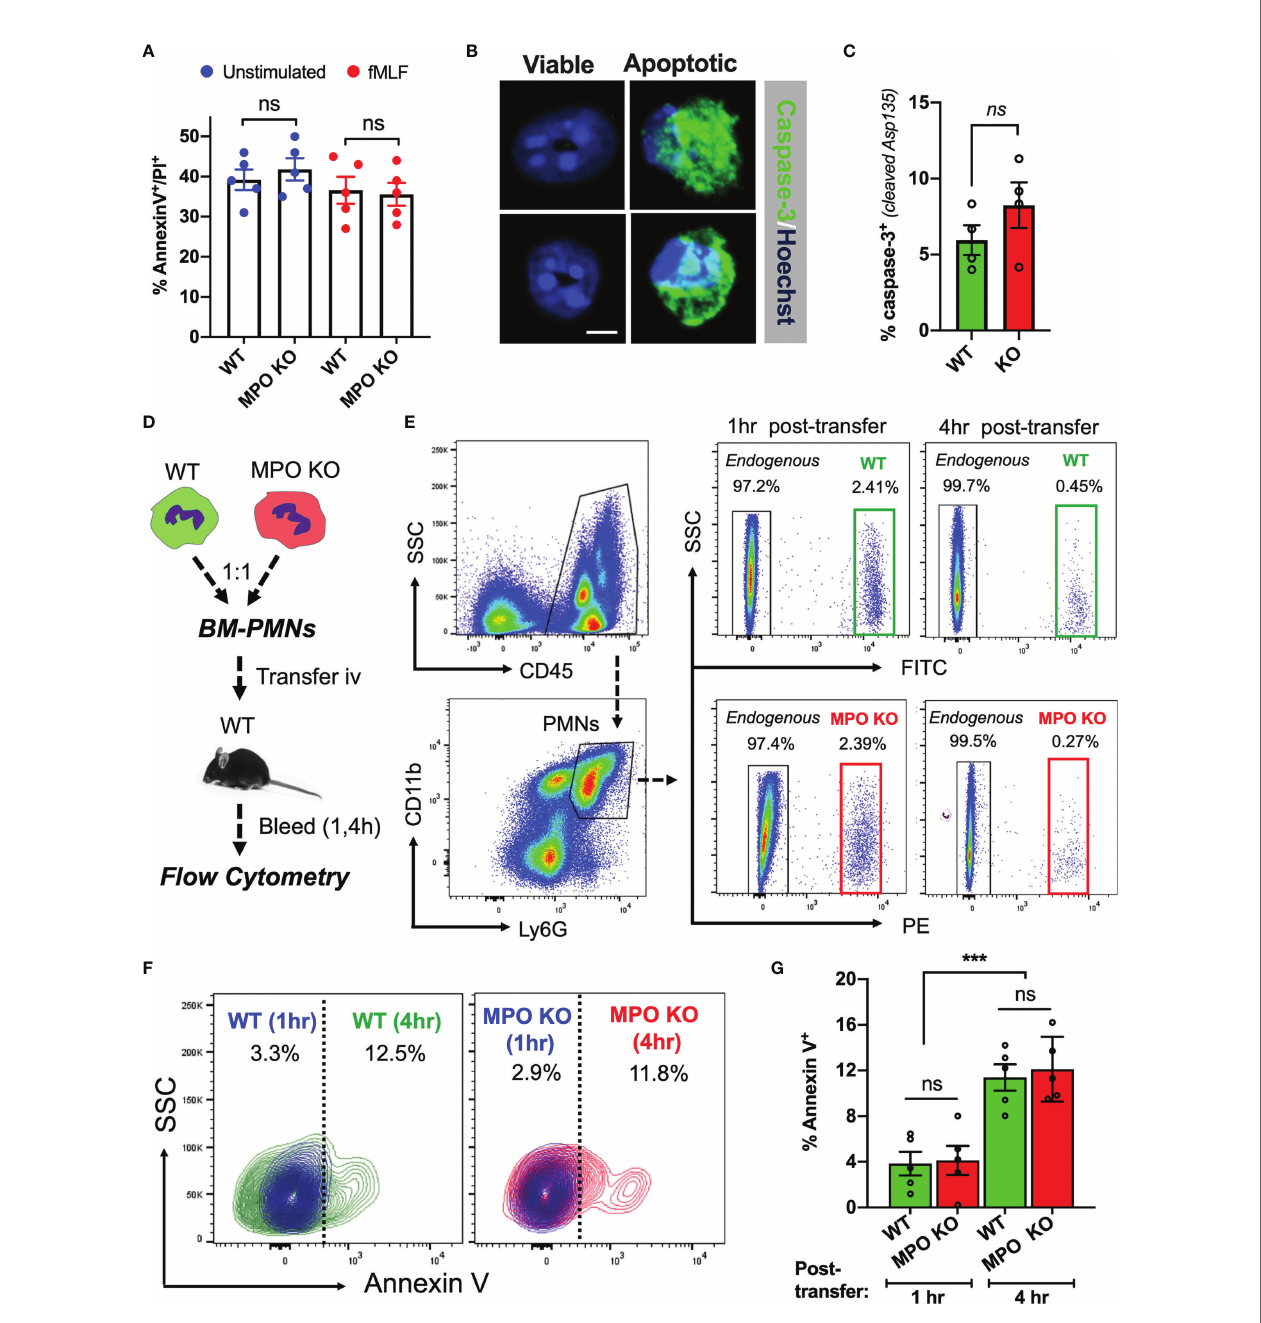
FIGURE 2 | MPO expression does not impact PMN viability. (A) PMN viability was assessed in ex vivo cultured BM-derived PMNs with/without fMLF-stimulation using Annexin V/PI staining and fl ow cytometry. Data shown as percent Annexin V/PI positive cells at 24hr in cultures. No signi fi cant differences between MPO KO and WT mice were observed. N=5 independent experiments. (B, C) Representative images and quanti fi cation of cleaved caspase-3 in fMLF-stimulated BM-derived WT and MPO-KO PMNs. No signi fi cant differences between MPO KO and WT mice were observed. N=4 independent experiments. The bar is 5µm. (D – G) PMN viability was examined in vivo in adoptively transferred PMNs. (D) Schematic depicting experimental timeline. Freshly isolated murine WT and MPO KO BM-PMNs were respectively labeled with green and red fl uorescence (CellTracker) and injected intravenously at a 1:1 ratio into WT recipients that were pre-stimulated with IL-1 b (50ng, 1hr, ip., to induce systemic in fl ammation). Annexin V staining and fl ow cytometry was used to gauge viability of transferred and endogenous PMNs at 1 and 4hr. (E – G) Representative fl ow diagrams of the gating strategy to identify transferred and apoptotic WT and MPO KO PMNs and quanti fi cation of